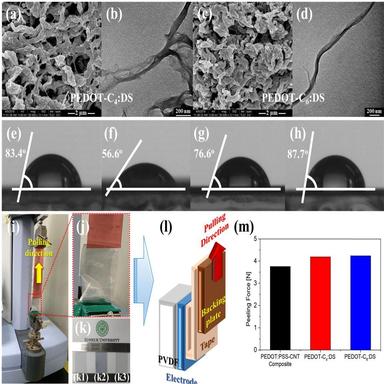
The FE-SEM (a and c) and TEM (b and d) images of PEDOT-C4:DS and PEDOT-C6:DS. Contact angle images of DI water droplets on PVDF (e), PEDOT:PSS-CNT composite (f), PEDOT-C4:DS (g), PEDOT-C6:DS (h) films. A photograph of peel-off tester (i), an enlarged photograph of a testing sample (j), and samples (k); PEDOT:PSS-CNT composite (k1), PEDOT-C4:DS (k2), and PEDOT-C6:DS (k3). Schematic illustration of 180° peel-off test of organic electrode layers coated on PVDF (l). Peeling force of each sample at 100 mm/min (m